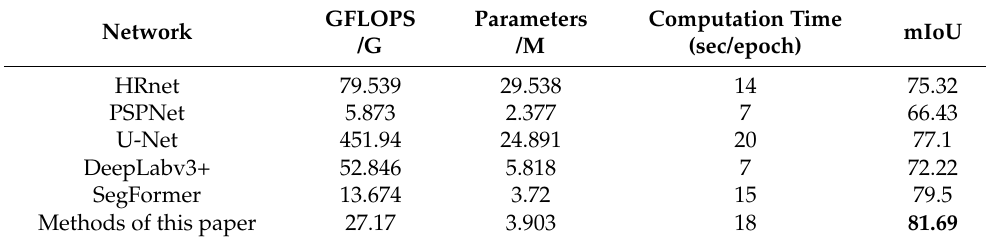
Table 7. Network complexity